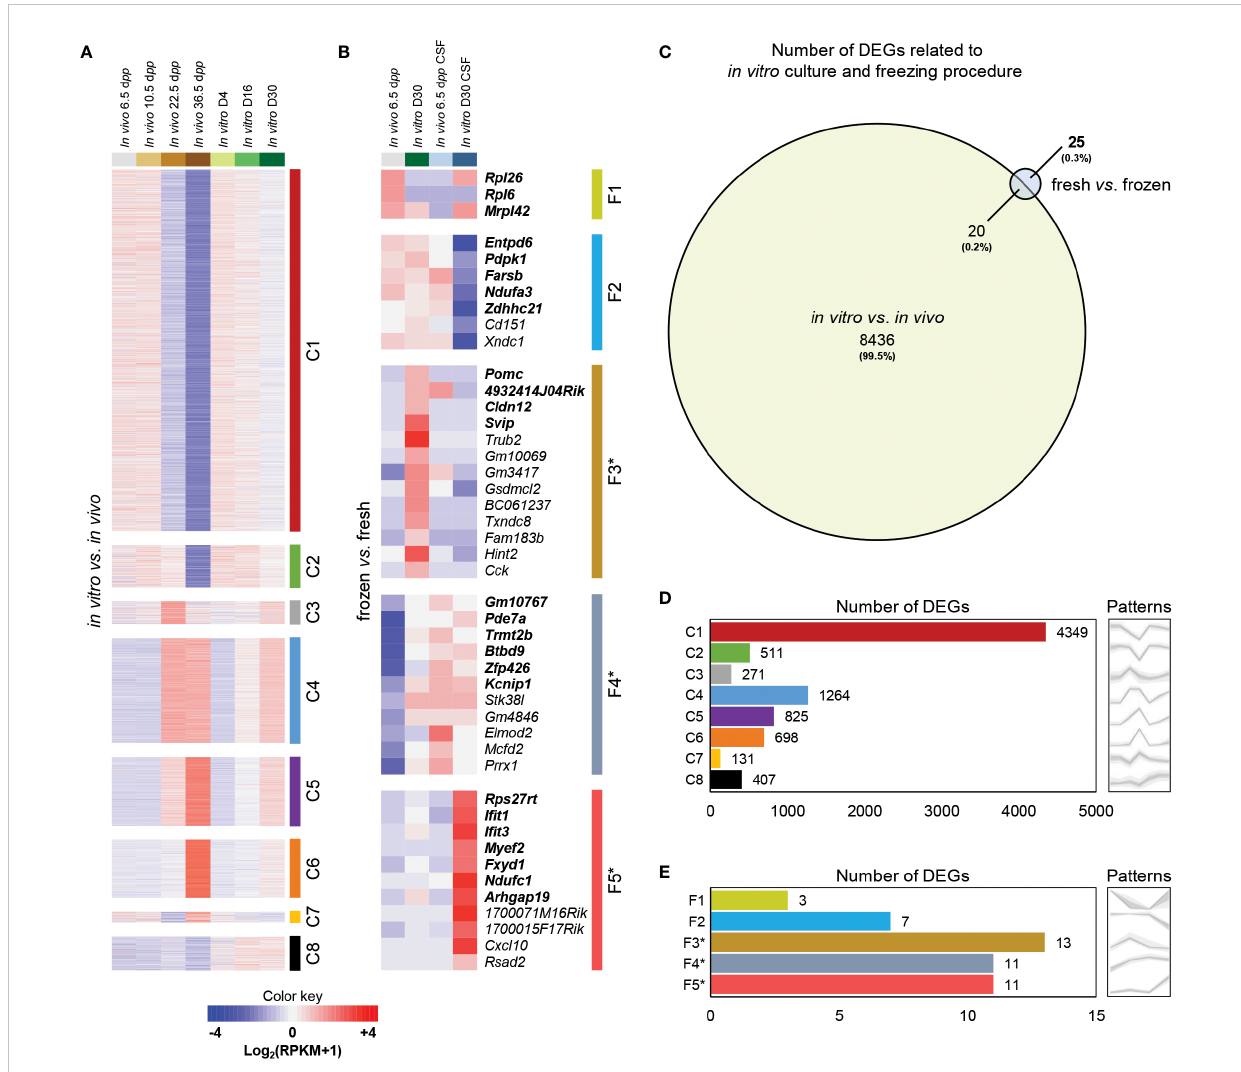
FIGURE 2 Global gene expression pro fi ling of testicular tissue samples in response to in vitro culture or freezing procedures. False-color heatmap summarizing the patterns de fi ning the global concentrations for transcripts across the entire sample set focused on the impact of in vitro culture (A) and freezing procedure (B) . Each row corresponds to the mean of biological replicate samples: in vivo 6.5 (fresh: n=3; CSF: n=2), 10.5 (n=3), 22.5 (n=3), 36.5 (n=2) d pp ; in vitro D4 (n=3), D16 (n=2), and D30 (fresh tissue: n=3; CSF: n=1). C1 to C8 and F1 to F5* refer to the individual patterns for the impact of in vitro culture and freezing procedure, respectively. DEGs only present for fresh vs . frozen are in bold. Fold change values are shown with a red or blue background indicating up-regulation or down-regulation, respectively. A color key-scale is shown for standardized values in Log 2 (RPKM+1). (C) Area-proportional Venn Diagram showing the overlap of signi fi cantly DEGs in in vitro vs . in vivo (with 8436 uniquely mapped transcripts from a total of 8456 DEGs) compared to fresh vs . frozen (with only 25 uniquely mapped transcripts from a total of 45 DEGs). Numbers labeled in each part show the amount of the genes with the corresponding expression patterns. The number of signi fi cantly DEGs included in each pattern are shown for the impact of in vitro culture (D) and freezing procedure (E) . Grey patterns are the graphical visualization of the average expression levels of the several patterns (with the variations between repetitions). F3* (23.1%), F4* (18.2%), and F5* (18.2%) were patterns with a large proportion of DEGs starting with ‘ Gm- ’ or ending with ‘ Rik ’ who are predicted genes or annotated genes that do not have a canonical name (yet). Based on